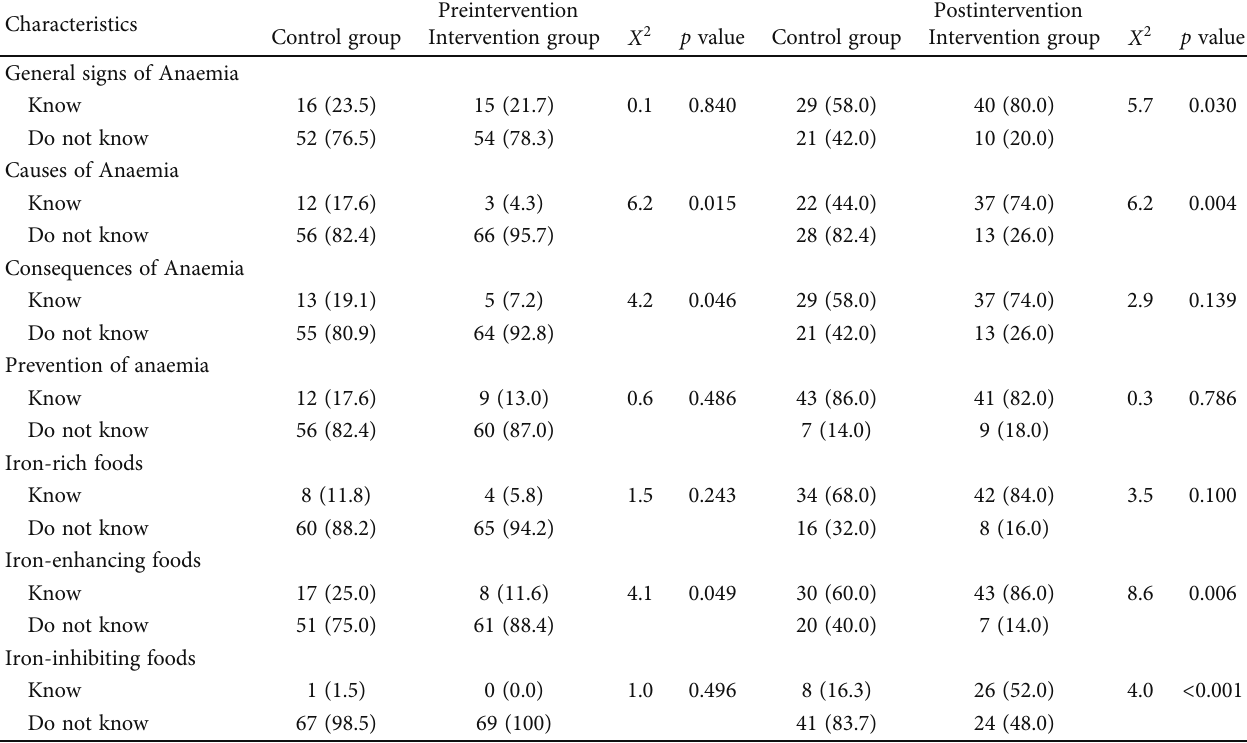
Table 3: Knowledge level of iron between the study groups at pre- and postintervention.